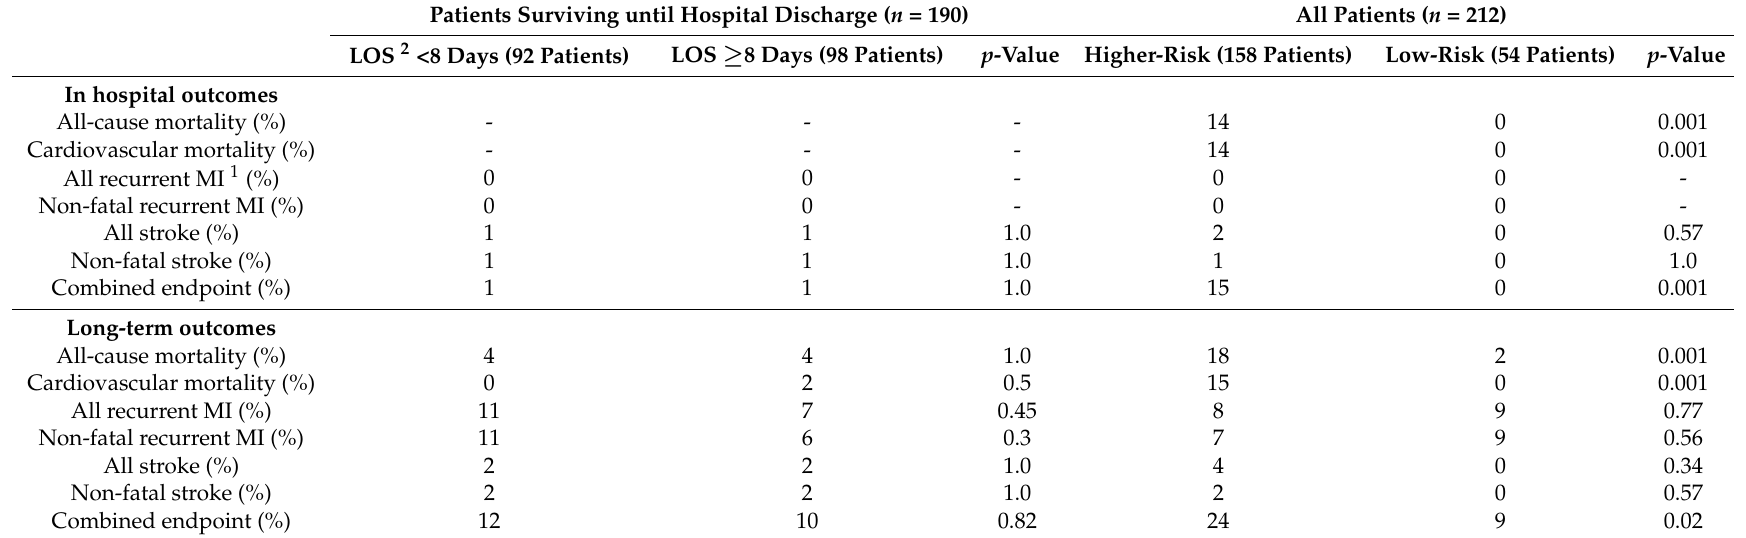
Table 5. Rates of events occurring during the hospital stay and